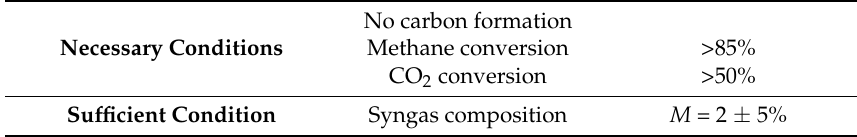
Table 5. Requirements for the reaction and